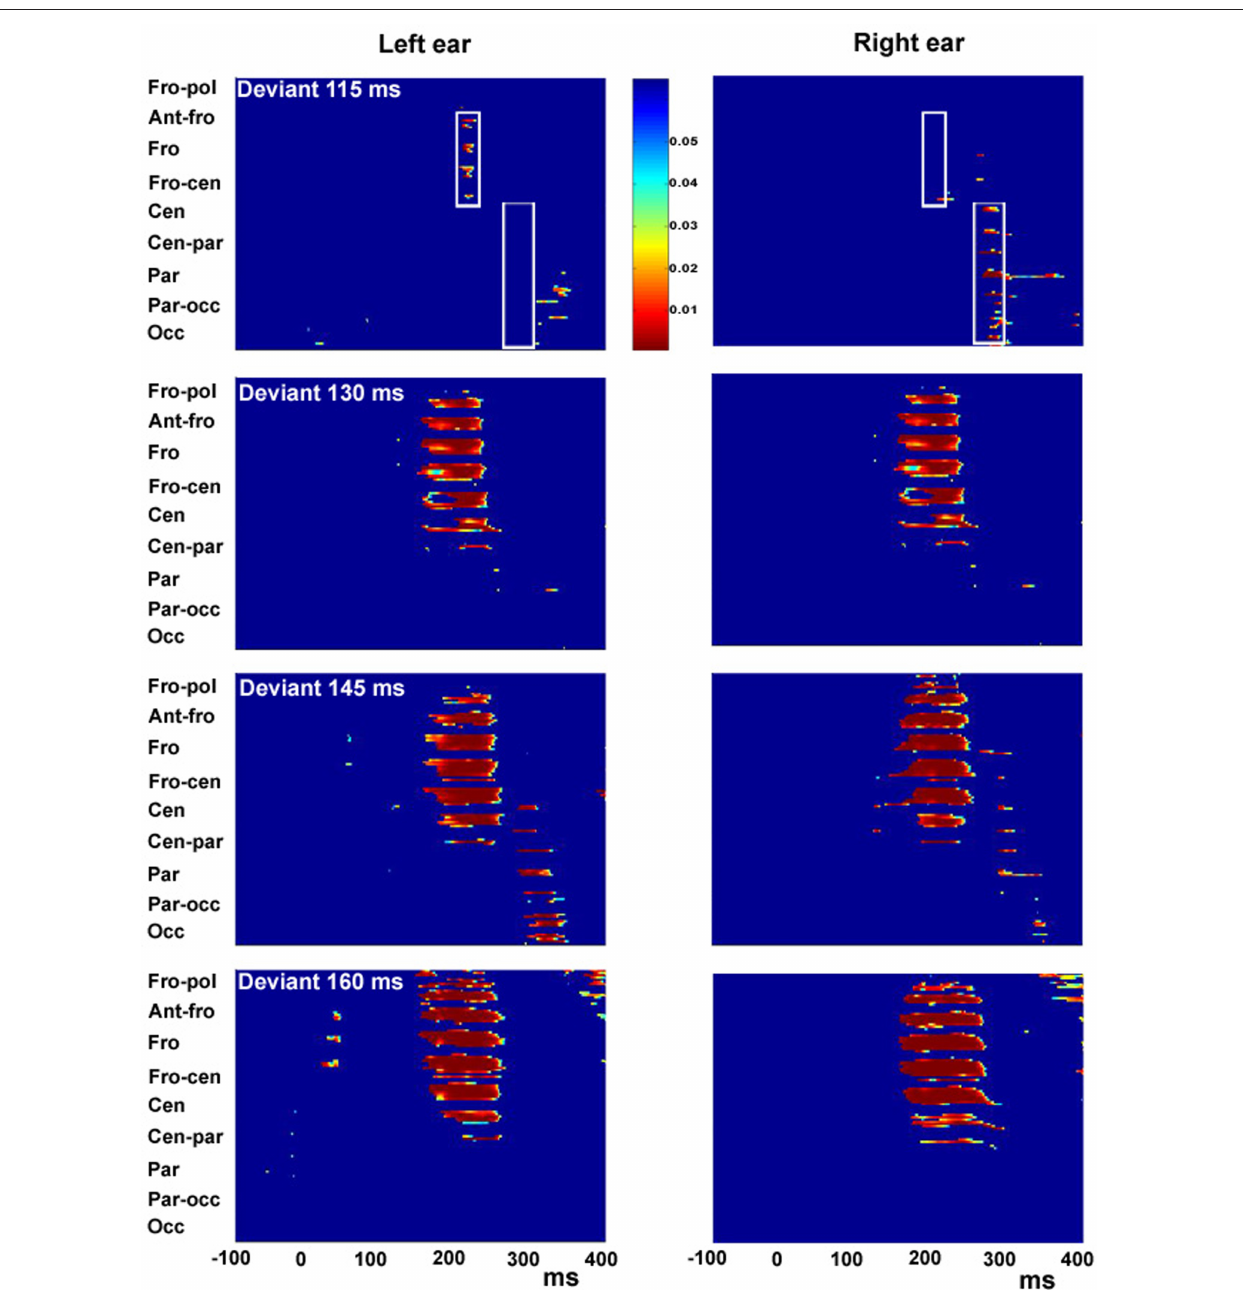
and electrode positions (y-axis) for the entire 128-electrode montage. For clarity, only p -values < 0.05 are color encoded. Fro-pol, Fronto-polar; Ant-fro, Anterior- frontal, Fro, Frontal; Fro-cen, Fronto-central; Cen, Central; Cen-par, Central- parietal; Par, Parietal; Par-occ, Parietal-occipital; Occ,